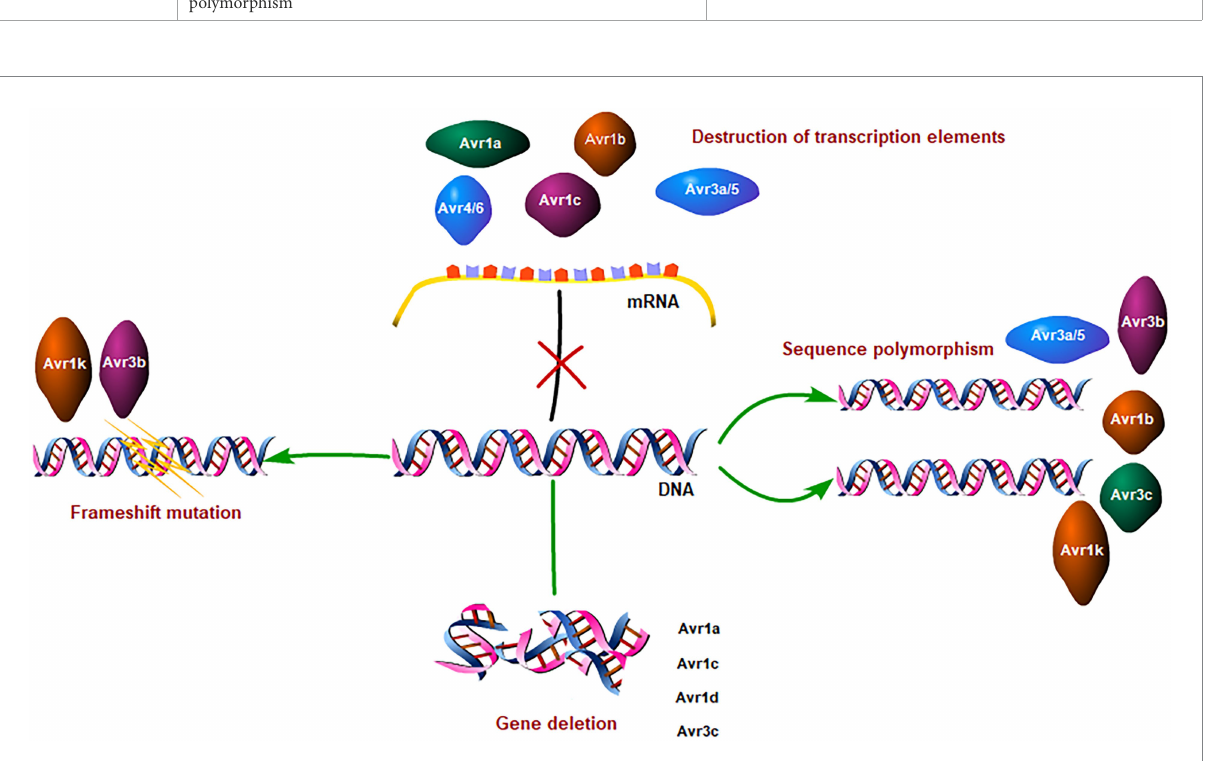
FIGURE 1 Immune evasion strategies of Phytophthora sojae